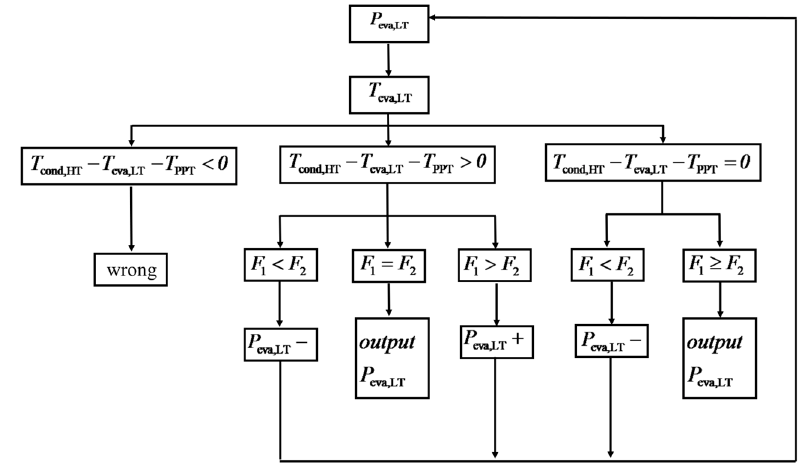
P calculation in case a. Figure 8. Flow chart of the P eva,LT calculation in case a.